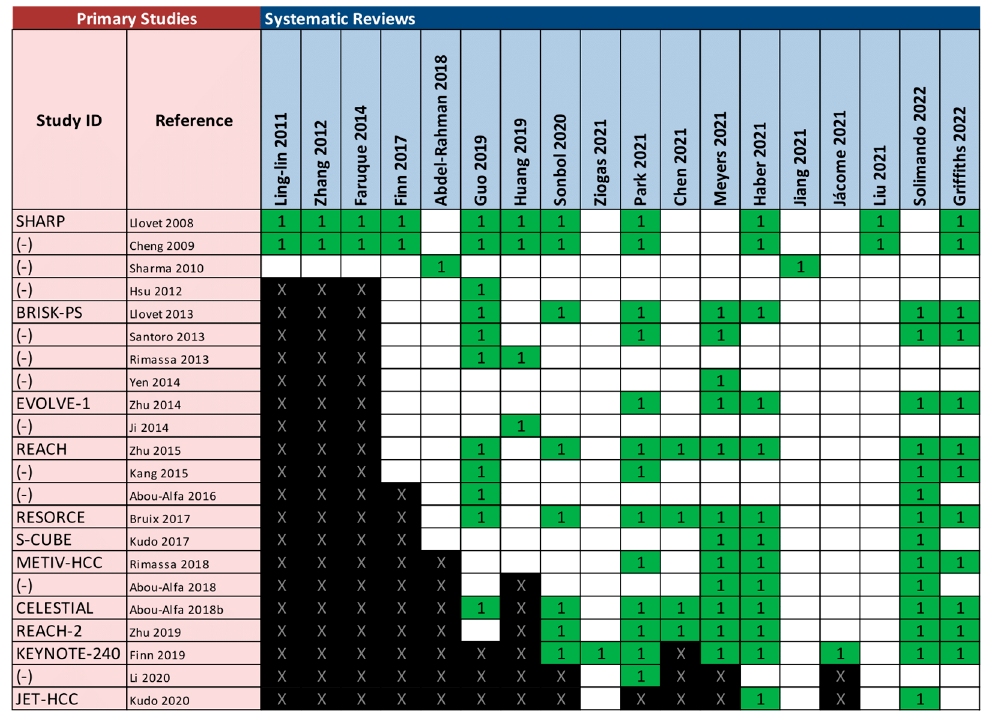
Figure 2. Matrix of evidence. All the included SRs are listed in the columns. All the relevant primary studies (i.e., those reporting at least one outcome of interest for the studied interventions) are listed in the rows. ‘1’ represents a primary study included in a specific SR. ‘X’ represents chronological structural missingness, that is, a primary study that cannot possibly be included in a SR, given that its publication date was more recent than the search date of the SR.